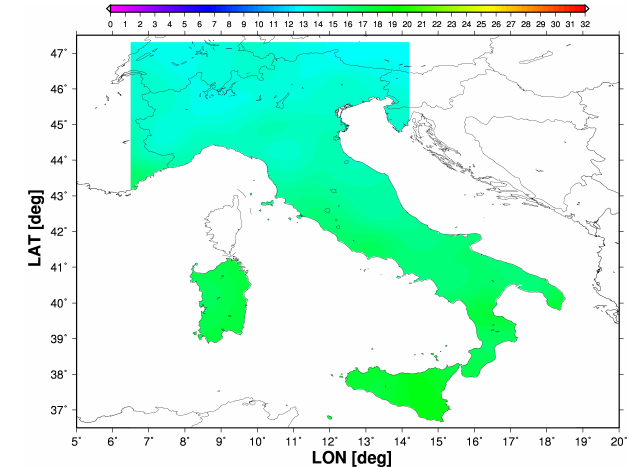
Figure 2. 1961–1990 yearly average global radiation MJ / day × m 2 on flat